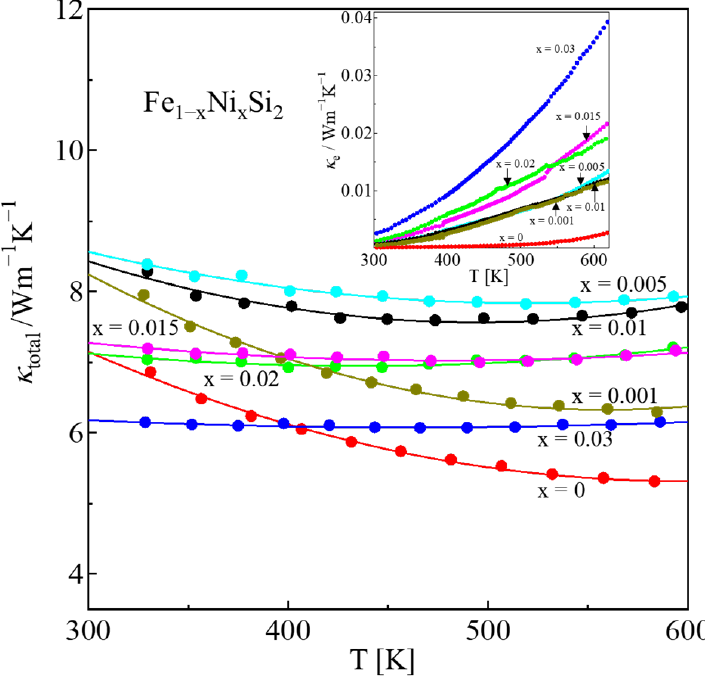
Figure 8. Thermal conductivity ( κ total = κ L + κ e ) of β -Fe 1 − x Ni x Si 2 (0 ≤ x ≤ 0.03) with respect to temperature, where the inset plots the electronic thermal conductivity ( κ e = L o T / ρ